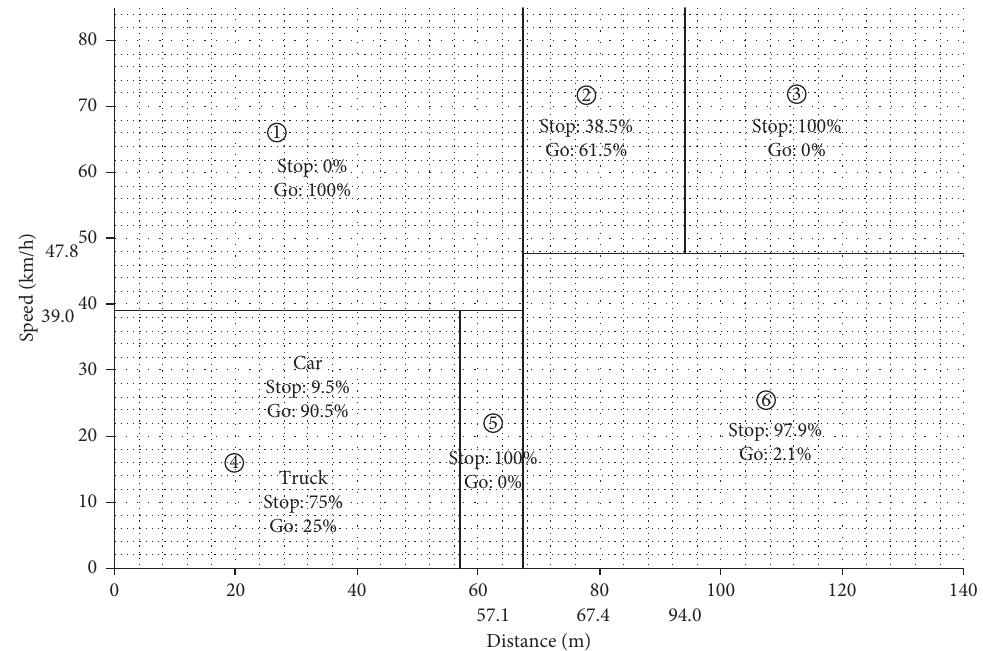
Figure 7: Partition for the stop/go decision model for urban